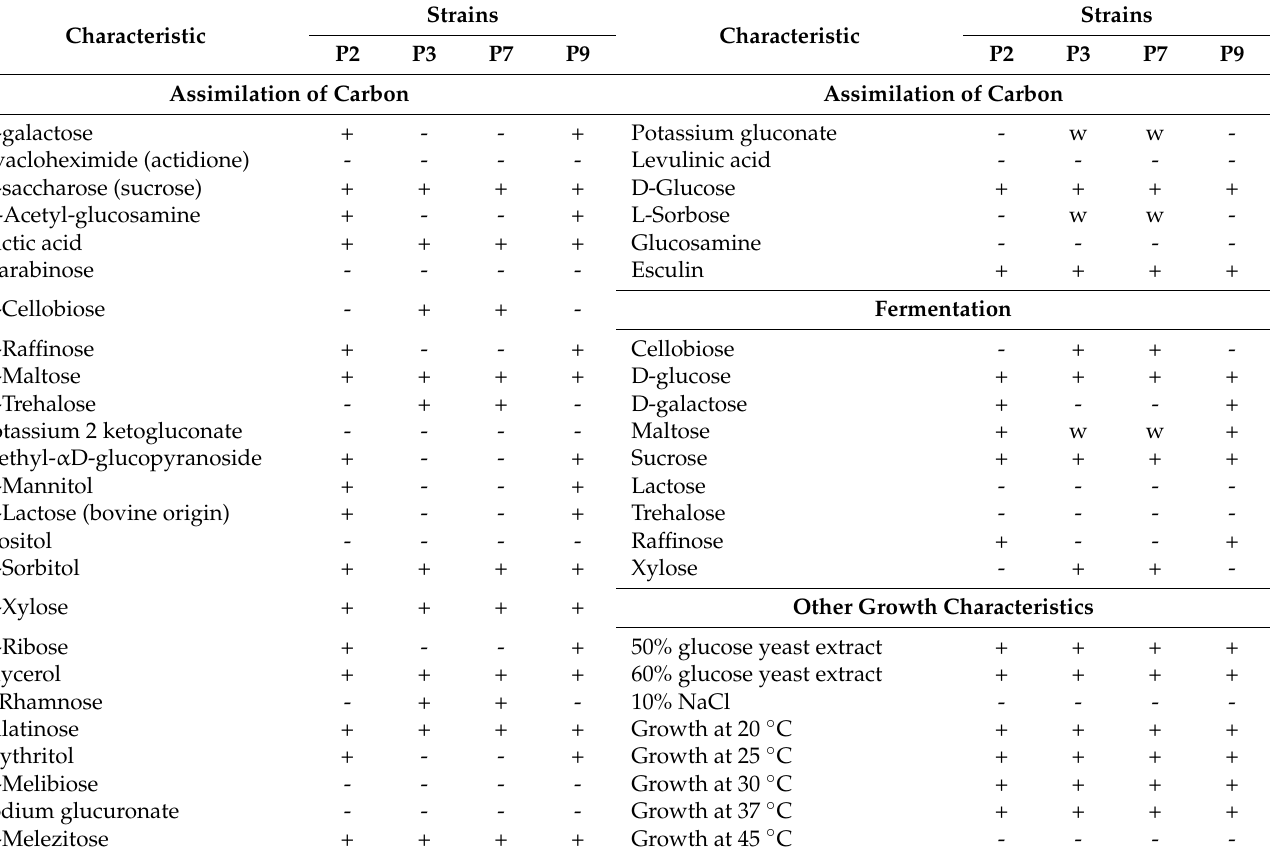
Table 2. Carbon fermentation and assimilation characteristics of the four selected yeast